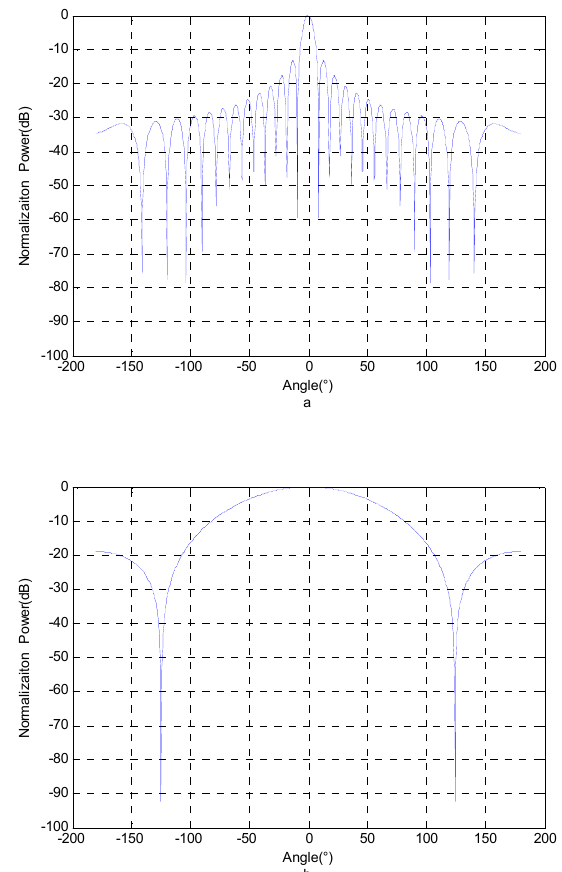
Figure 2. The normalization beam patterns of the radar and EW system’s antennas: ( a ) normalization beam pattern of a radar antenna; ( b ) normalization beam pattern of an EW system antenna. EW, electronic warfare.